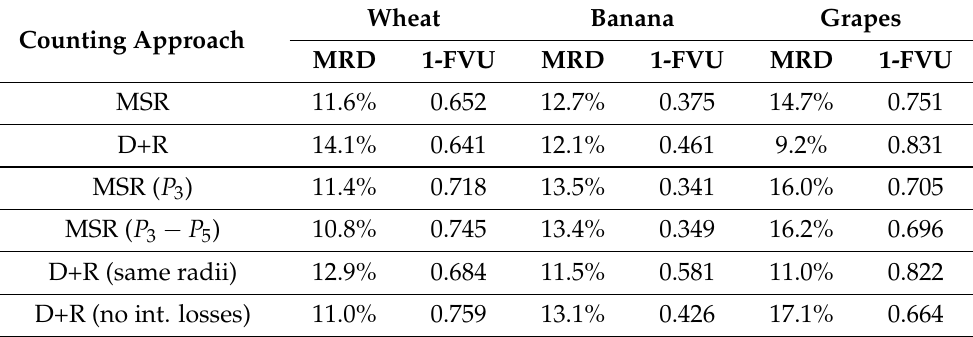
Table 4. Part counting results for the three datasets, compared to several counter ablations. The first two rows show the results obtained by the original MSR (with 5 resolutions, P 3 − P 7 ) and D+R approaches. The last four rows show the results of variations. For MSR we have tested the method using fewer resolutions: 3 resolutions P 3 − P 5 and a single resolution P 3 (the most detailed). For D+R a variation in which the learned heat maps are generated with fixed kernel size (same radii) was tested, as well as a version without guiding intermediate losses (no int.